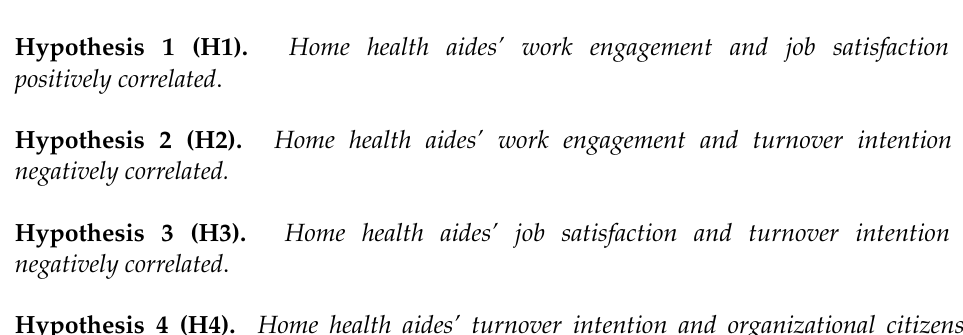
Figure 1. The Framework of Research Model.